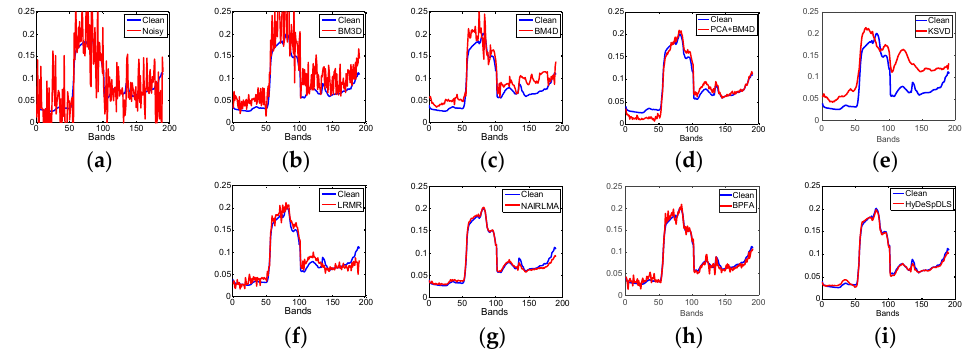
Figure 6. Denoised spectral signature results of Washington DC Mall data with Gaussian non-i.i.d. noise: ( a ) Noisy; ( b ) BM3D; ( c ) BM4D; ( d ) PCA + BM4D; ( e ) KSVD; ( f ) LRMR; ( g ) NAILRMA; ( h ) BPFA; and ( i ) HyDeSpDLS. Electronics 2019 , 8 , x FOR PEER REVIEW 15 of 19